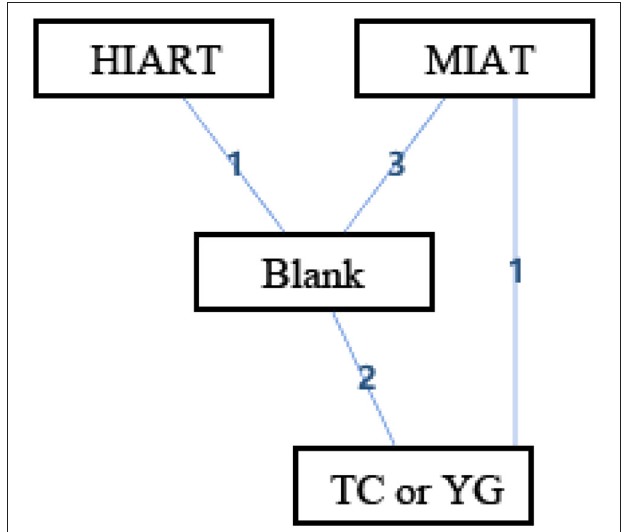
FIGURE 5 | The network structure of intervention of superoxide dismutase (SOD). Blank, Blank control; HIART, High intensity aerobic mixed resistance training; MIAT, Medium intensity aerobic training; TC or YG, Tai Chi or Yoga. The numbers on lines represent the number of studies that make direct comparisons between interventions.